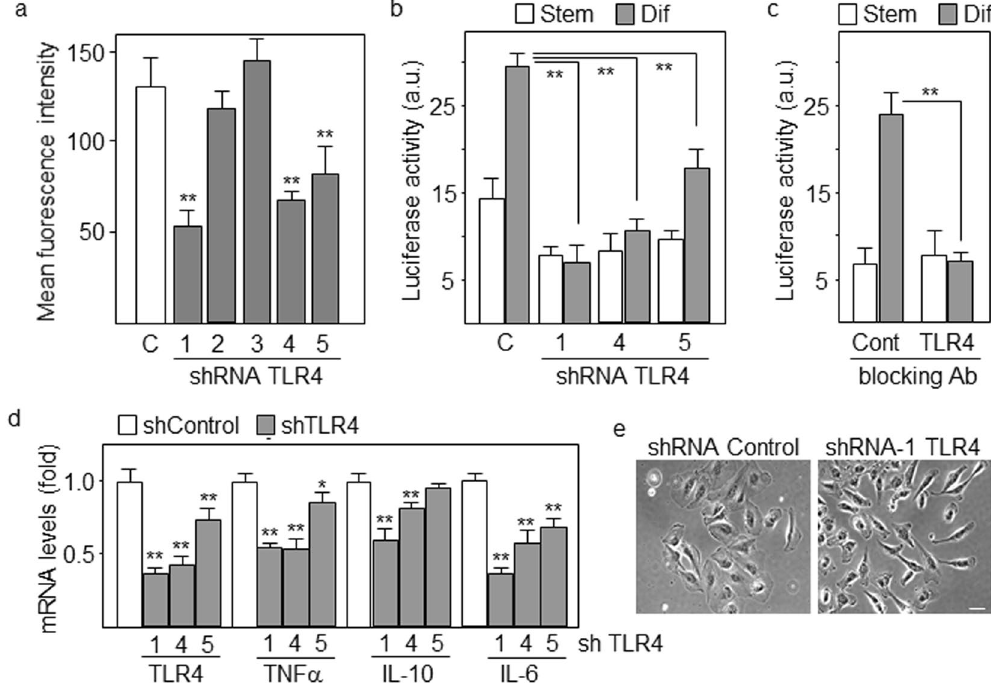
Figure 2. Downregulation of TLR4 blocks differentiation-induced activation of NF κ B. (a) Protein levels of TLR4 are significantly reduced ( ** p < 0.01) in GBM cells with three out of five non-overlapping TLR4-specific shRNAs as determined by flow cytometry. ( b , c ) NF κ B transcriptional activity following differentiation of GSCs transfected with TLR4-specific shRNAs ( b ) or cultured in the presence of TLR4 blocking antibodies ( c ). ( d ) Downregulation of TLR4 levels produced a decrease in the expression of NF κ B target cytokines as determined by real-time PCR. ( e ) Morphological changes in GSCs with reduced levels of TLR4 after 4 days of differentiation. Scale bar: 50 μ m. Histograms represent the mean ± SD of three independent experiments. ** p < 0.01. a.u., arbitrary